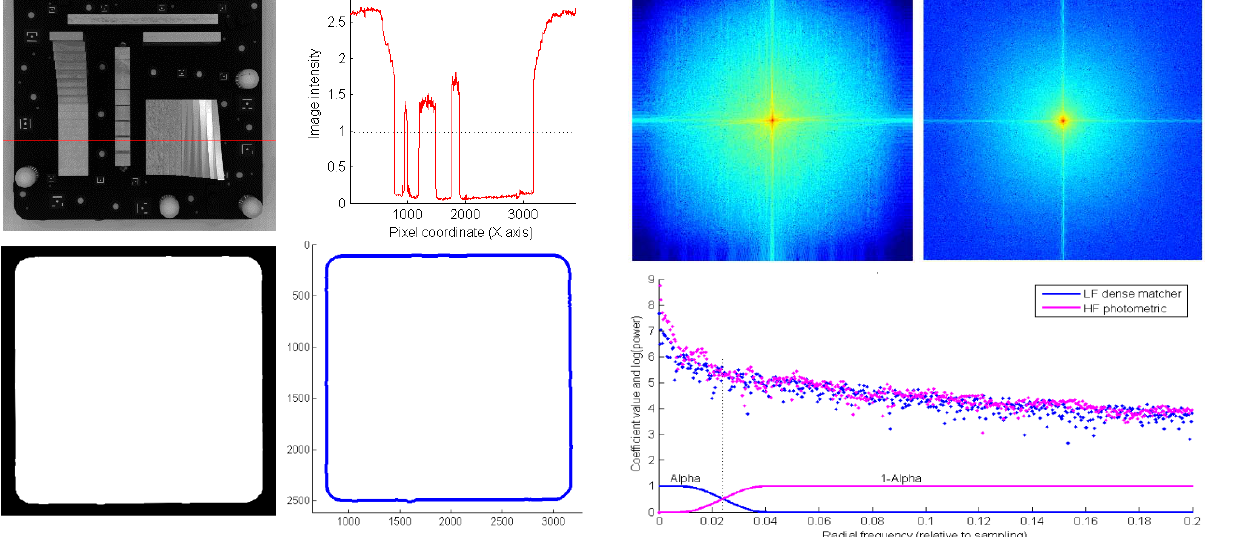
Figure 16. (top left) log power spectrum of DEM generated from dense matcher point cloud; (top right) log power spectrum of photometric gradients; (bottom) slices of log spectra and